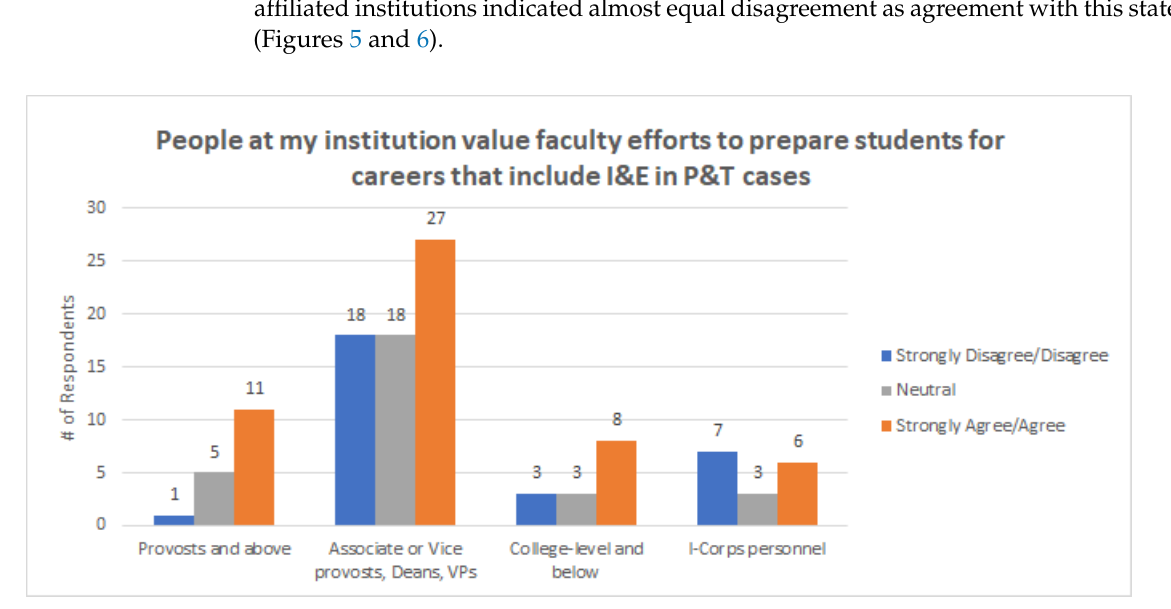
Figure 4. Comparison of institution type responses about rewarding faculty members’ I&E in P&T as important for retaining faculty at the institution.